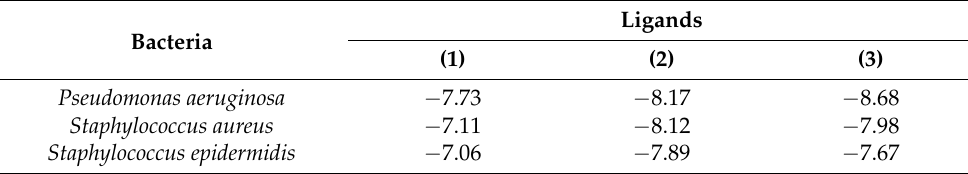
Table 3. The docking score (interaction energy (Kcal/mol)) for ligands with the active side of the